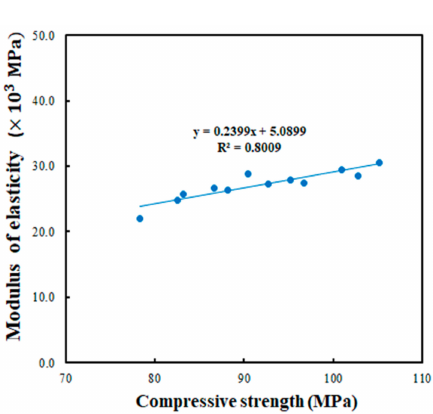
Figure 7. Relation between compressive strength and modulus of